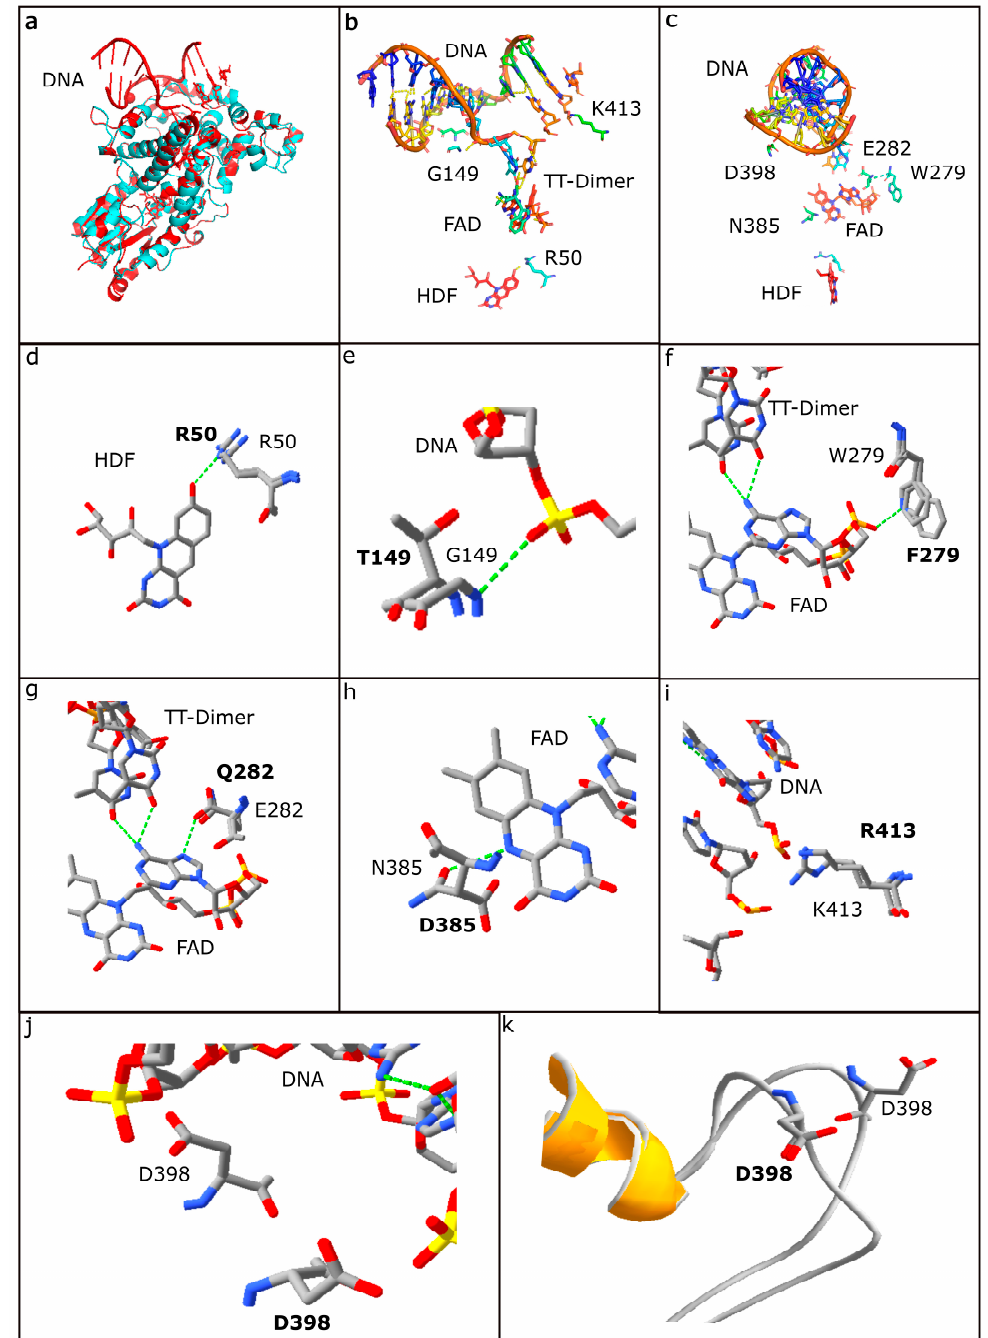
Figure 5. Crystal structure of S . elongatus PCC 6301 (SEL) photolyase compared to the Halobacterium sp. NRC-1 Phr2 model (amino acids shown in bold), including key amino acid positions, visualized using PyMOL (panels ( a – c )) and Swiss-Pdb Viewer (panels ( d – k )). ( a ) The ribbon structure of the SEL photolyase (red) superimposed with the NRC-1 Phr2 model (blue); ( b ) bound DNA, including CPD dimer analog (TT-Dimer), of the SEL photolyase along with the FAD and HDF cofactors interacting with nearby amino acids; ( c ) bound DNA of SEL photolyase rotated by 90 degrees. ( d ) Residue R50 in SEL shown superimposed with corresponding R residue in NRC-1; ( e ) G149 in SEL shown superimposed with T in NRC-1; ( f ) W279 in SEL shown superimposed with F in NRC-1; ( g ) E282 in SEL shown superimposed with Q in NRC-1; ( h ) N385 in SEL shown superimposed with D in NRC-1; ( i ) K413 in SEL shown superimposed with R in NRC-1; D398 in SEL and D in NRC-1 are shown in stick ( j ) and ribbon models ( k